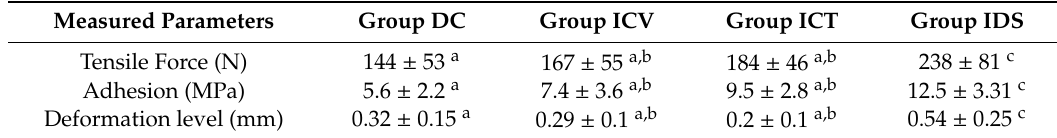
Table 2. Mean ± standard deviation of maximum tensile force, adhesion and deformation levels observed in each experimental group. The same uppercase small letters indicate no significant di ff erence in each row according to 1-way ANOVA, Tukey’s and Tamhane post-hoc tests ( p < 0.05). Measured